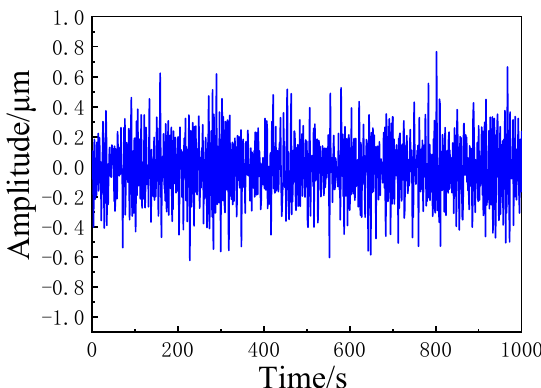
Figure 10. Time history of measurement point 1 under condition 2.